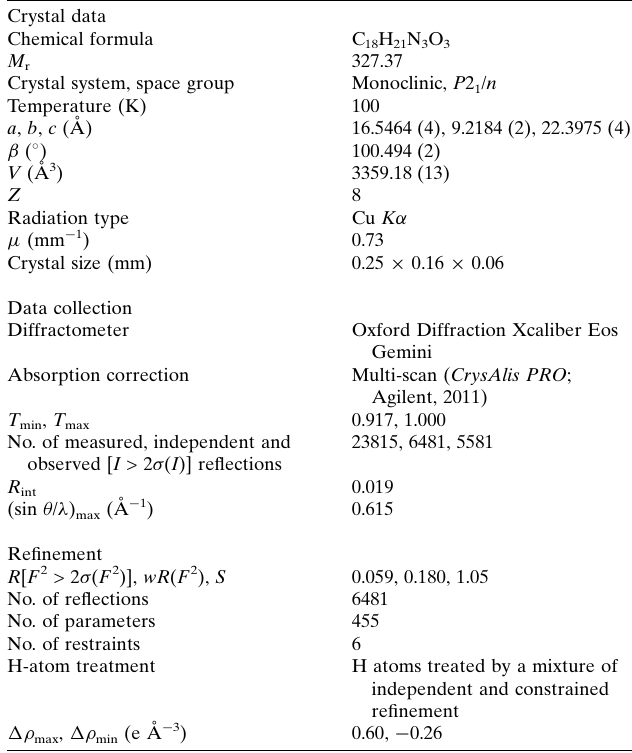
Crystal data Chemical